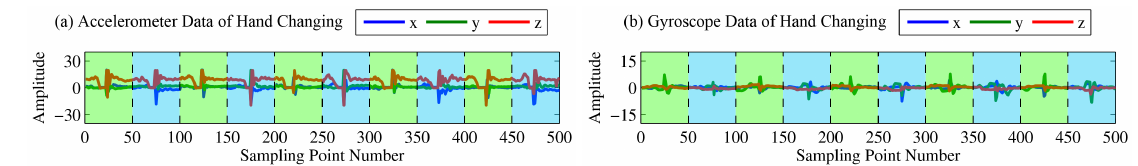
Figure 12. Accelerometer ( a ) and gyroscope ( b ) data of hand changing.